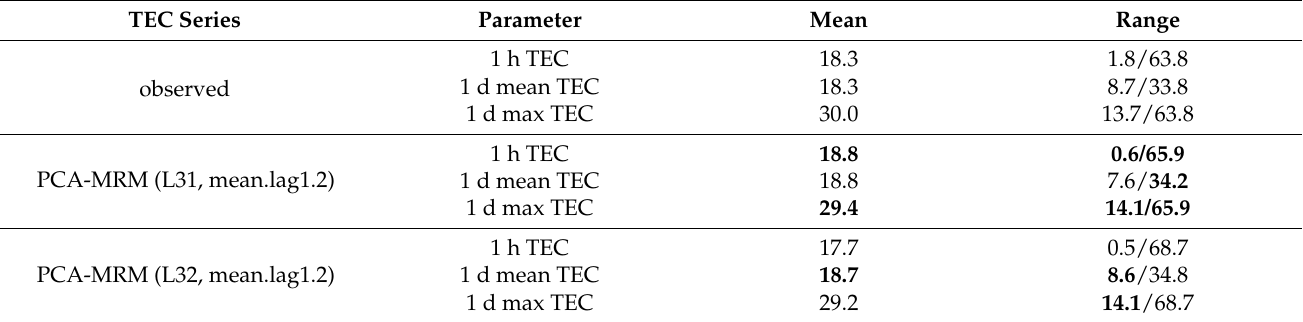
Figure 5. Observed (black) and forecasted using the PCA-MRM (L31, mean.lag1.2) model (red) 1 h TEC series for February 2015; pink area shows 90% confidence interval (larger version can be found in SM, Figure S9). Table 1. The mean values and the range (in TECu) for different TEC parameters for the observed and forecasted series: 1 h TEC series, 1 d mean and 1 d maximum TEC series. Metrics of the models that are most close to the metrics of the observed TEC series are in bold.